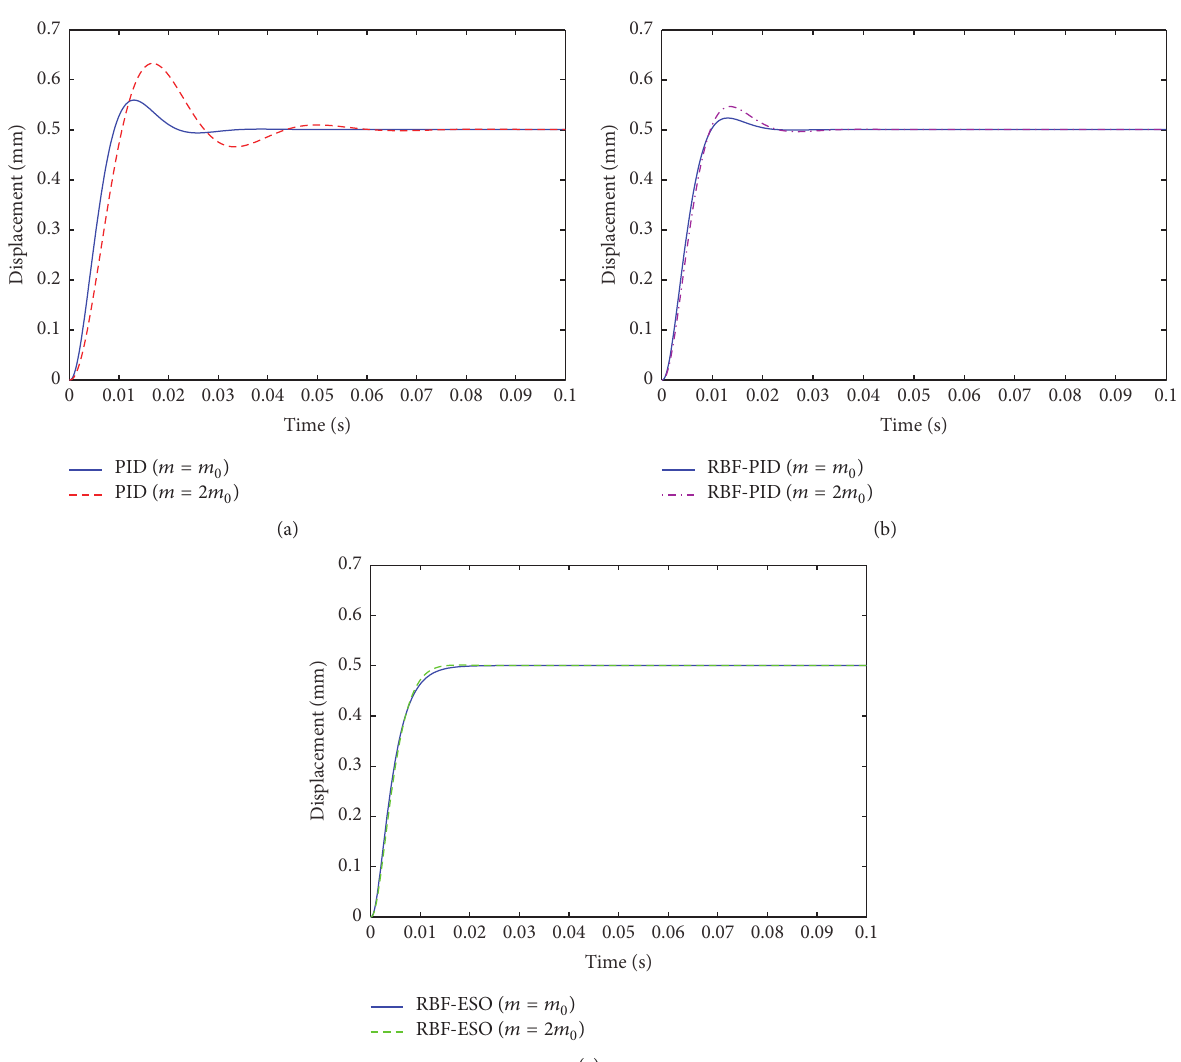
Figure 6: Tracking of position step response by different algorithms.